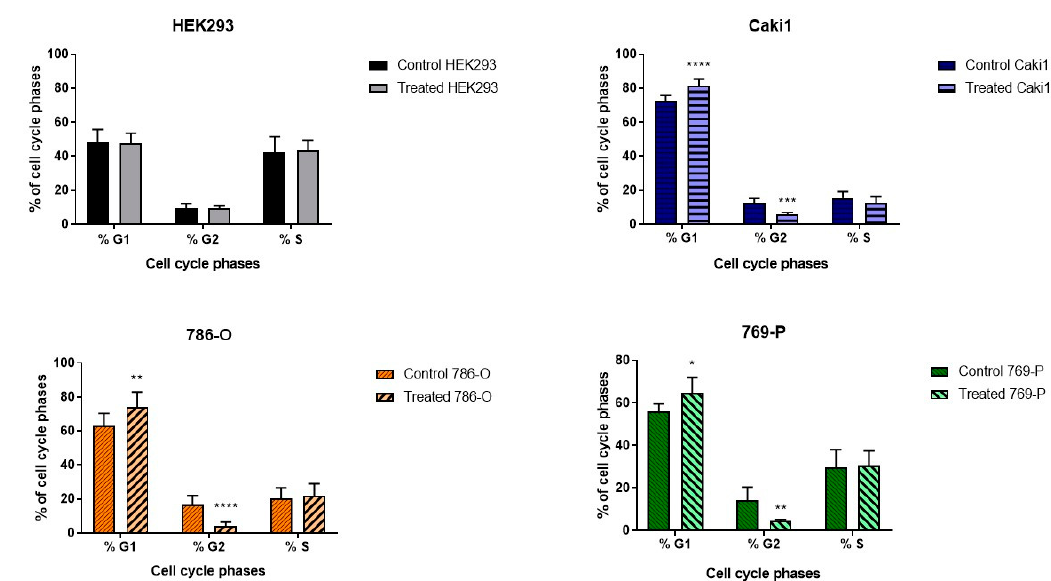
Figure 1. Results of cytometric analysis of cell cycle phases under the influence of 4.5 mT, 50 Hz extreme low-frequency electromagnetic field (ELF-EMF). Data presented as mean ± standard deviation: *— p < 0.05, **— p < 0.005, ***— p < 0.001, **** p < 0.0001.